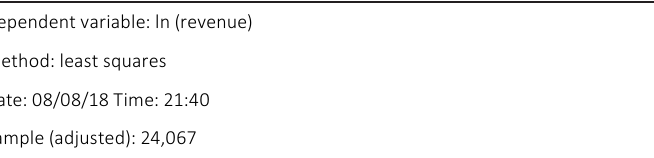
Table A4. Estimation result of model (2) with D